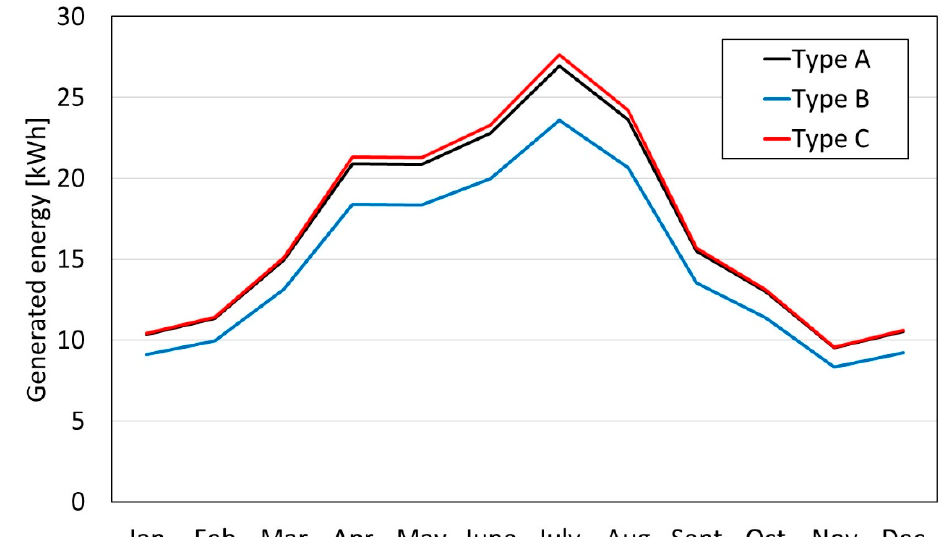
Figure 3. Energy generated by different PV modules. Table 4. Investment required for each PV panel model. Table 3. Common costs for PV system accessories.